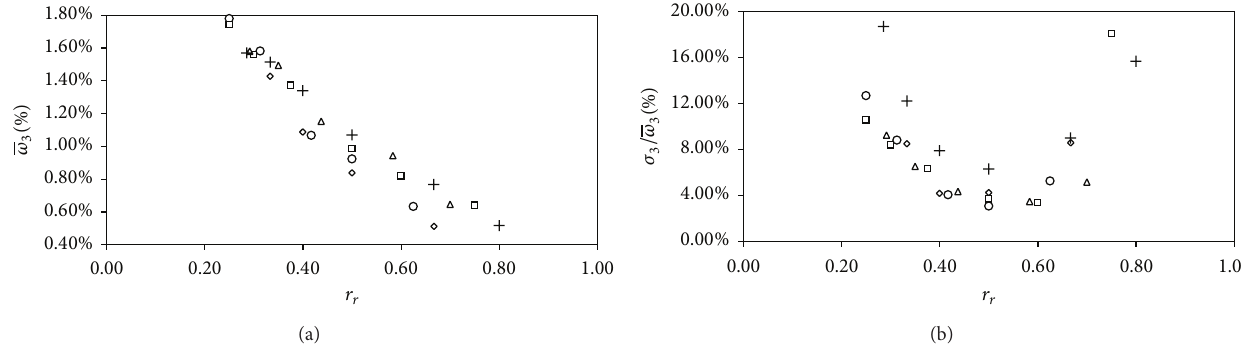
Figure 6: Averaged third harmonic term, 𝜔 3 , regarding the conical cups rotors (a), and the corresponding standard deviation, 𝜎 3 /𝜔 3 (b), both expressed as a function of the parameter 𝑟 𝑟 ( 𝑟 𝑟 = 𝑅 𝑐 /𝑅 𝑟𝑐 ). The symbols correspond to rotors equipped with the following cup radii: = 20 mm (rhombi), 𝑅 = 25 mm (circles), 𝑅 = 30 mm (squares), 𝑅 = 35 mm (triangles), and 𝑅 = 40 mm (crosses). 𝑅 𝑐 𝑐 𝑐 𝑐 𝑐